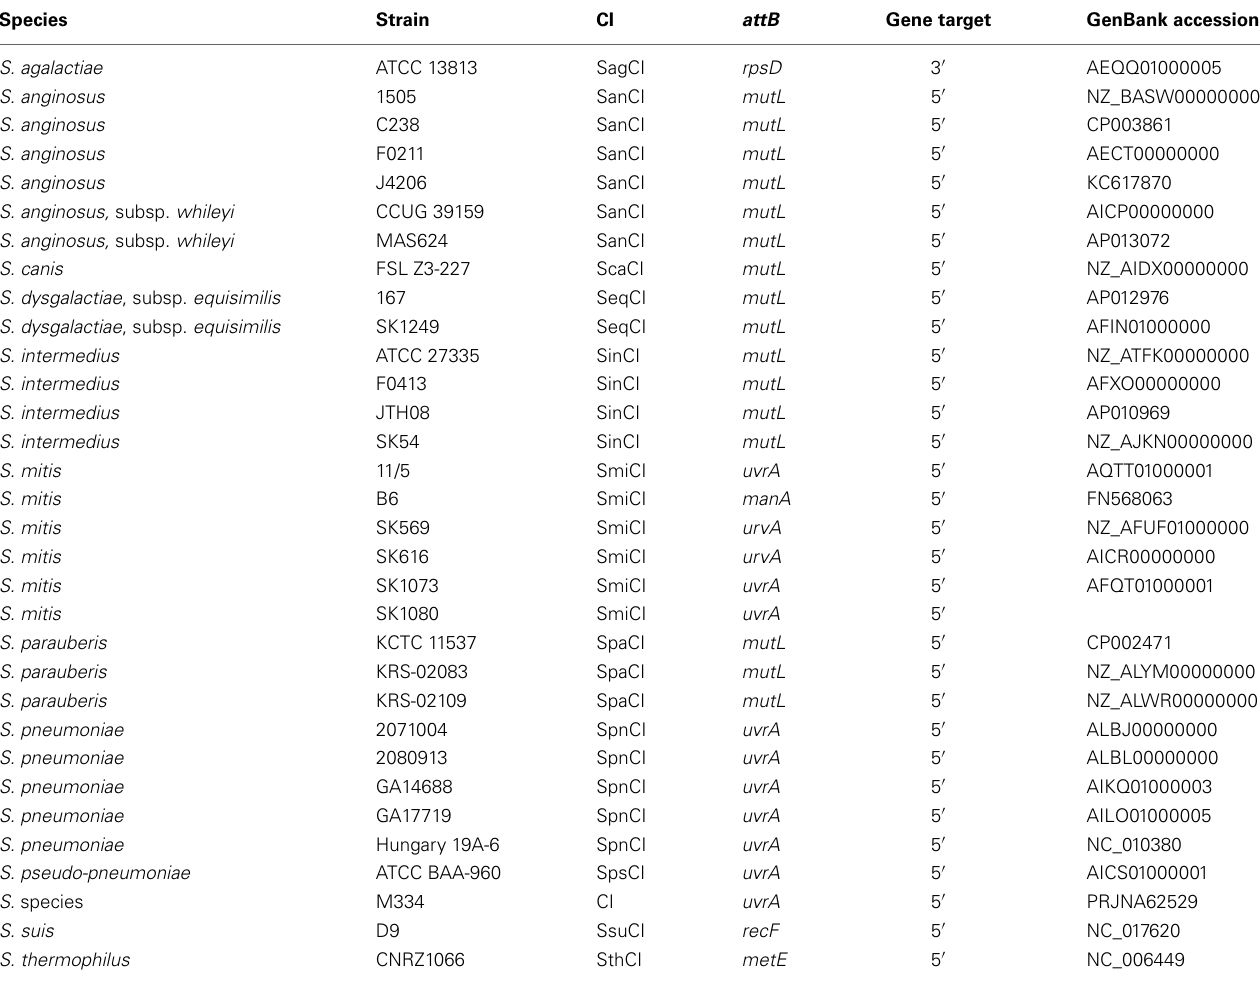
Table 2 | Chromosomal islands identified in other streptococcal species that target mutL or other genes for integration.